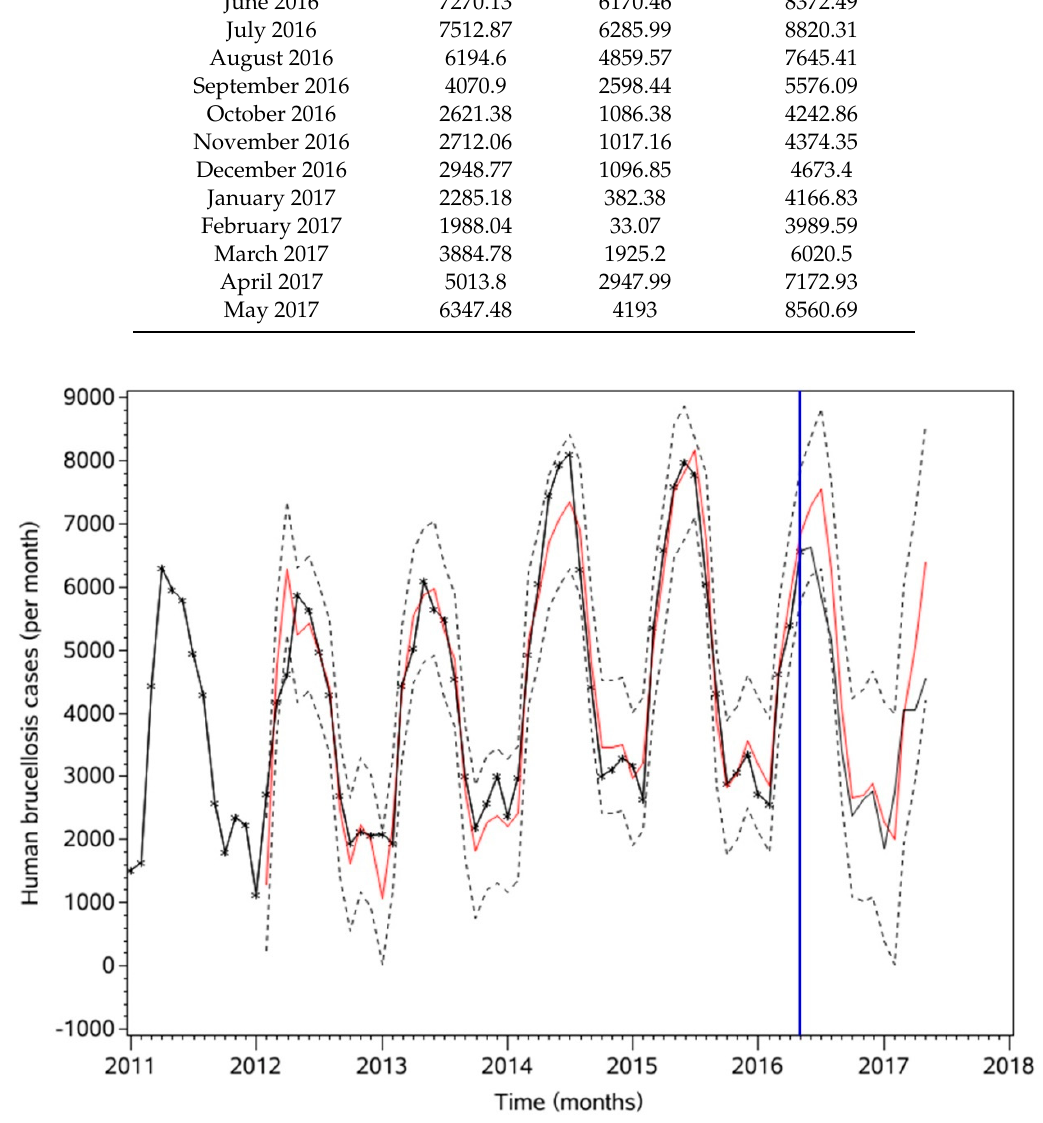
Figure 4. Brucellosis fitting and prediction (January 2011–May 2017). The black line represents actual observations. The red line to the left of the blue vertical line represents fitted values, while that to the right of the blue line represents predicted values. The dotted black lines represent 95% confidence intervals.